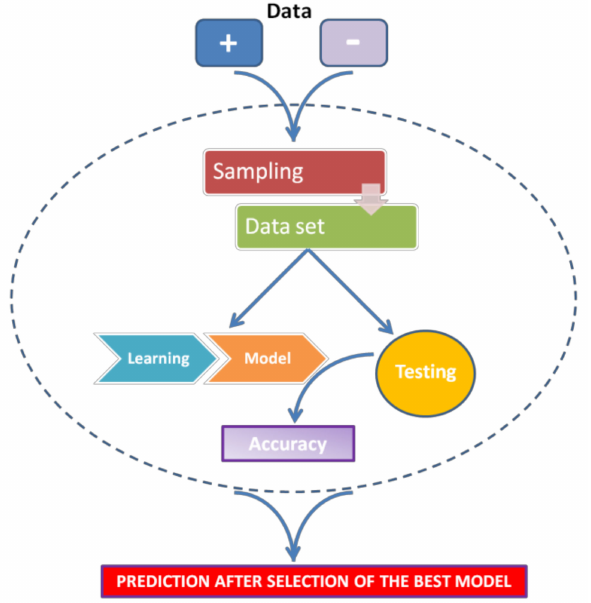
Figure 3. Scheme of Machine Learning general